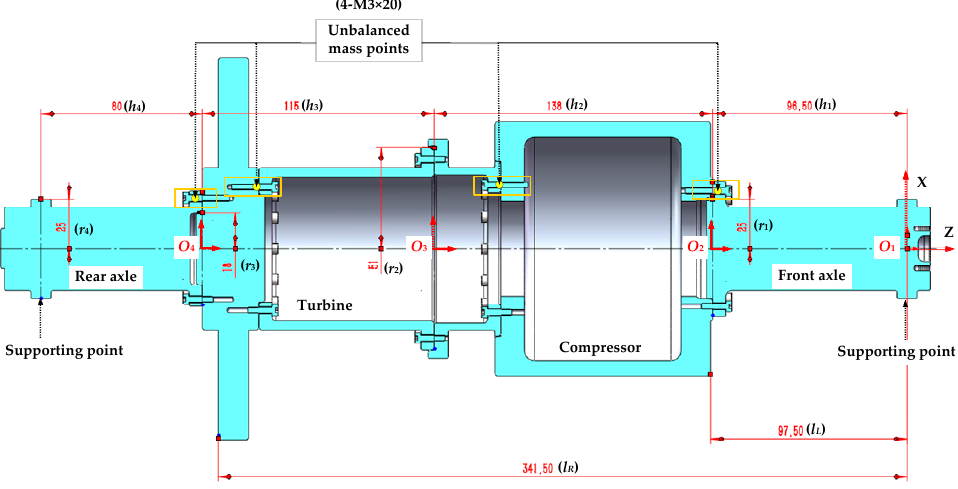
Figure 6. The section view of a simplified four-stage high-pressure rotor system of an aero-engine. The setup of the geometric parameters ( c n , θ n , p n , r n , h n , δ n , q n ) of the rotors at each stage is shown in Table 1. The distances ( l L and l R ) between the supporting point and the pre-set balancing surfaces L and R , are 97.5 mm and 341.5 mm, respectively. The four M3 screws with thread length of 20 mm are artificially used to replace the four M3 screws with thread length of 12 mm at the calibrated screw holes of rotors at each stage, in order to produce four unbalanced masses of 0.8 g. In Table 2, the coordinates of the unbalanced mass points in the local measuring coordinate system of the front axle ( O 1 ( x , y , z )), the compressor ( O 2 ( x , y , z )), the turbine ( O 3 ( x , y , z )), and the rear axle ( O 4 ( x , y , z )) are meas- ured by the 3D drawing software SOLIDWORKS. Table 1. The setup of the geometric parameters of the high-pressure rotor system. Component c [mm] θ [°] p [mm] r [mm] h [mm] δ [°] 12 Table 2. The setup of the unbalanced masses and the corresponding coordinates in the high-pressure rotor system. Component